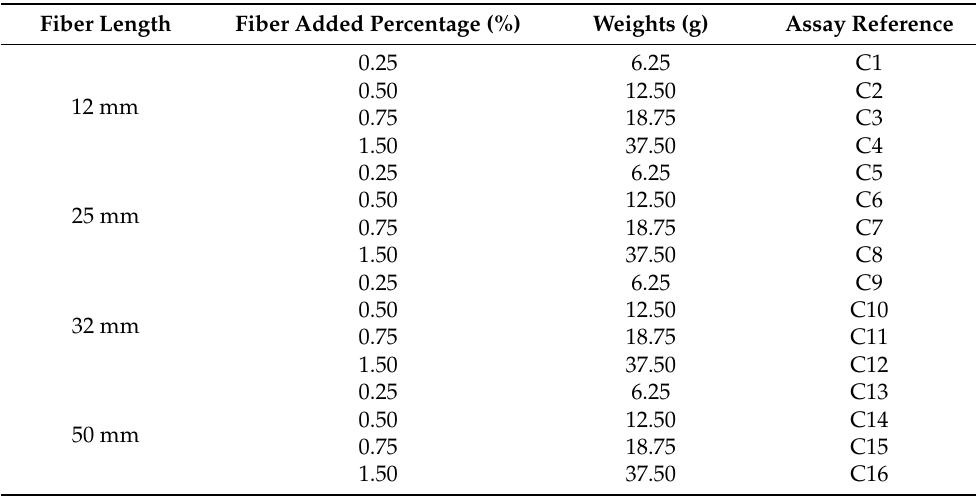
Table 5. Sizes, proportions and amount of fiber per 2500 g of plaster.